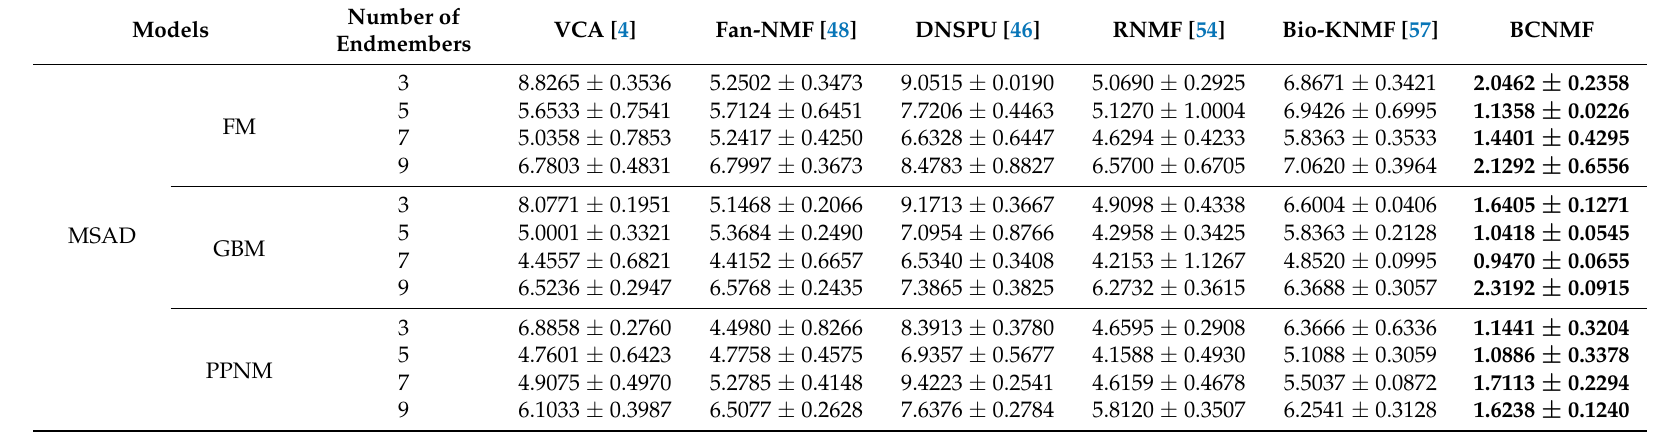
Table 4. MSADs of all algorithms with different numbers of